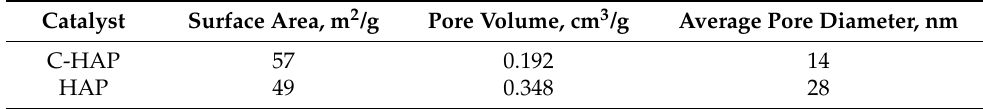
Figure 4. Characteristics of N 2 -adsorption measured with C-HAP powder material: ( a ) N 2 -adsorption– desorption isotherms; ( b ) pore size distribution. Table 1. Texture parameters of as-synthesized HAP and C-HAP